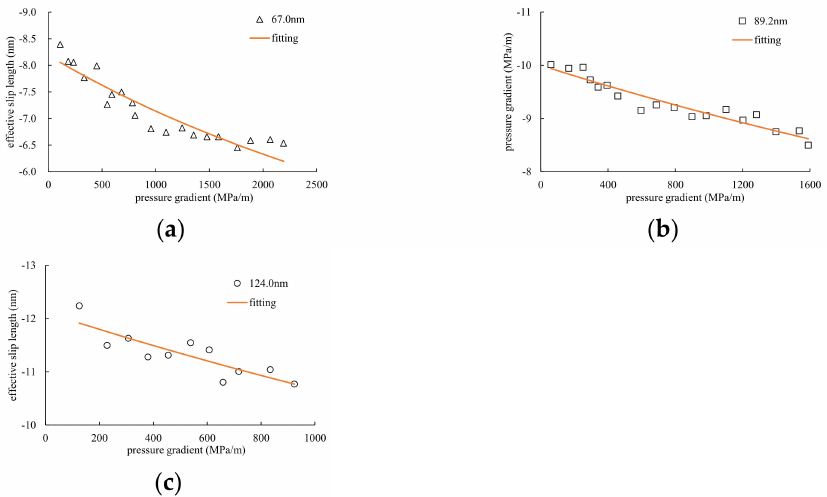
Figure 17. Relationship between effective slip length and pressure gradient. ( a ) The pore diameter is 67.0 nm, a = − 55,860, b = 6824, R 2 = 0.8672; ( b ) the pore diameter is 89.2 nm, a = − 99,290, b = 9930, R 2 = 0.9098; ( c ) the pore diameter is 124 nm, a = − 89,330, b = 7373, R 2 =